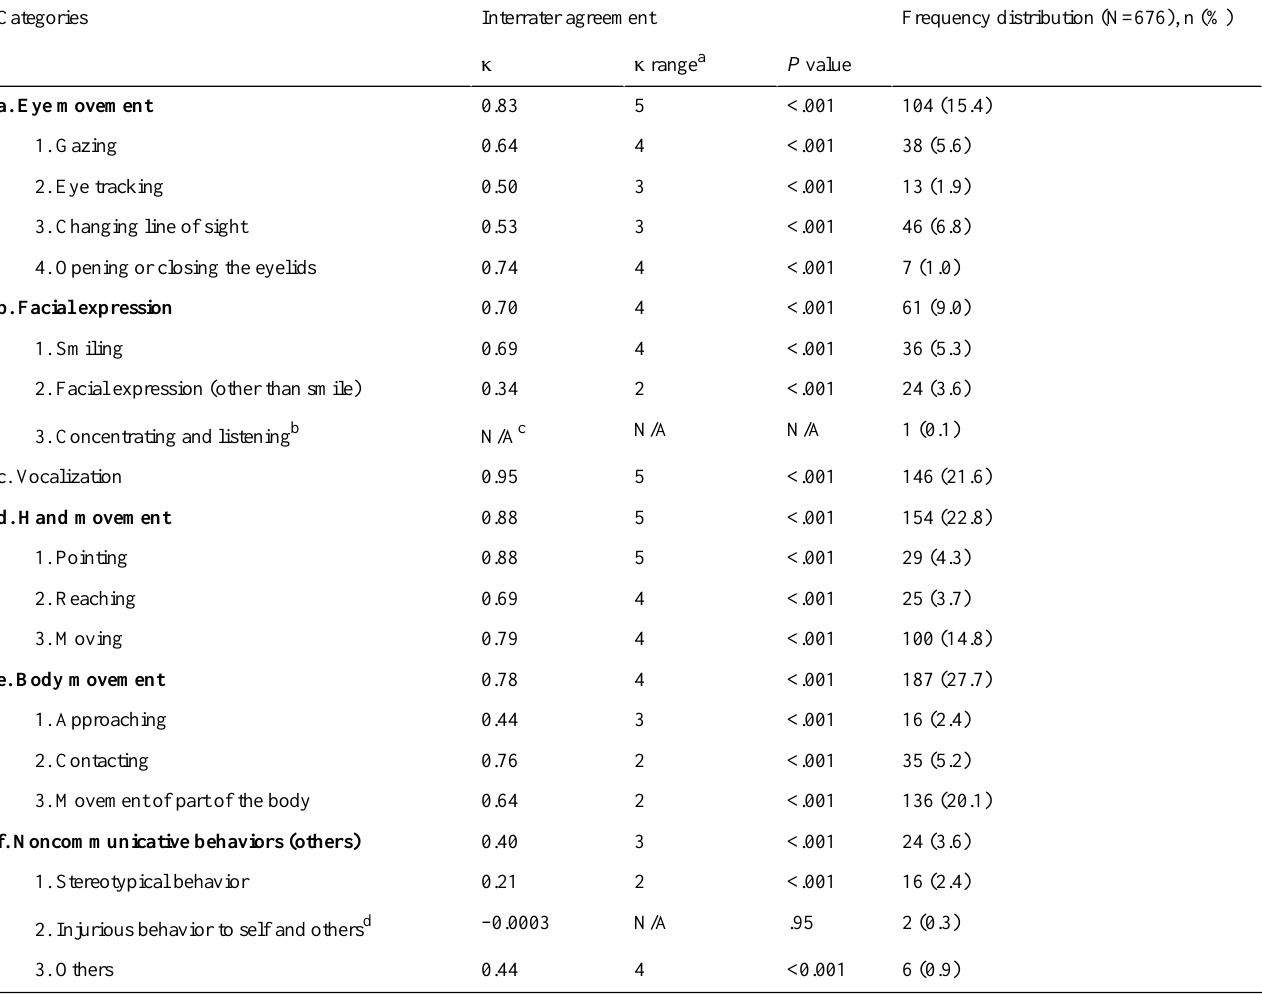
Table 2. Interrater agreement and frequency distribution of the major and minor categories of the table of expressions in children with profound intellectual and multiple disabilities or severe motor and intellectual disabilities